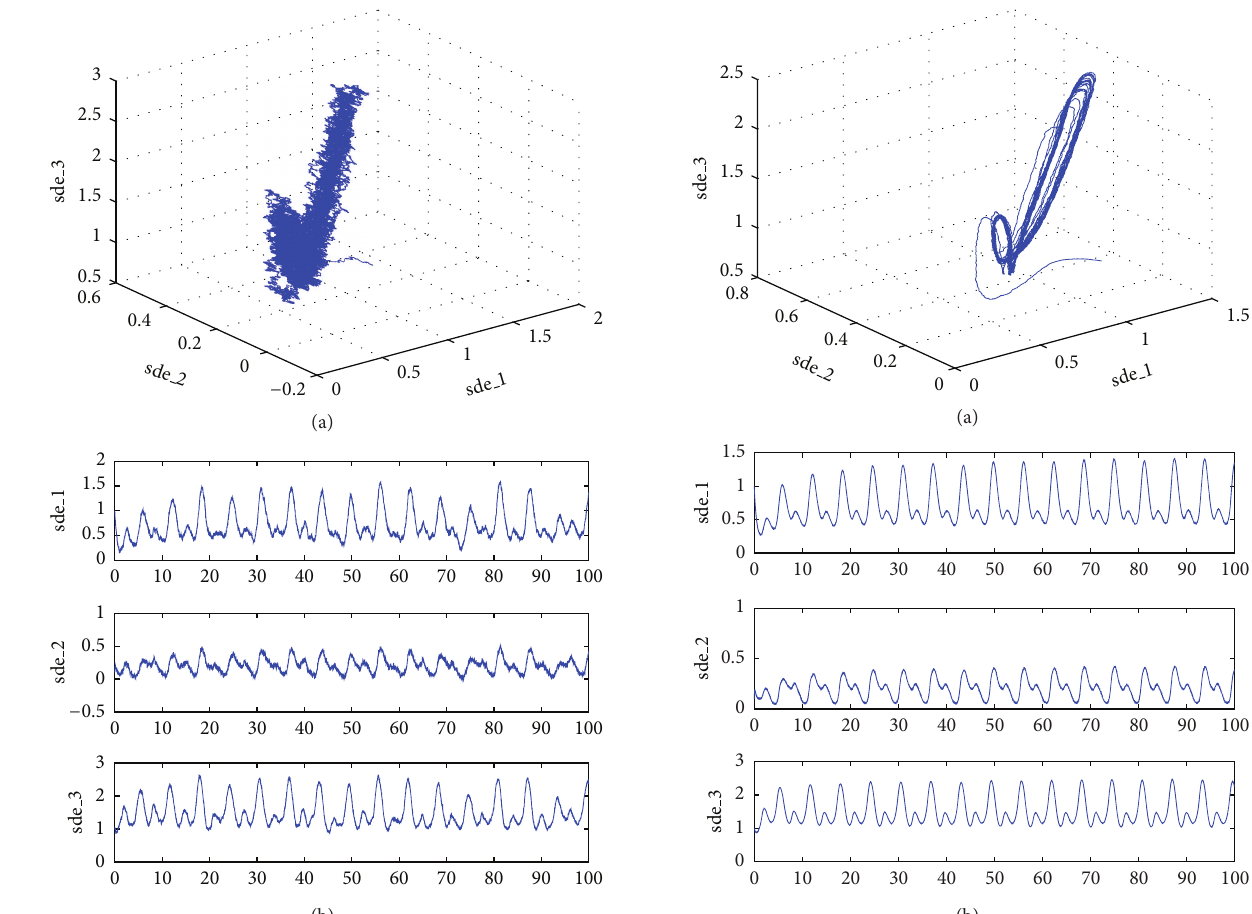
we consider 𝜎 = 12 , 𝑟 = −10 , 𝑎 = −7 , 𝑏 = 1 , 𝛽 = 2 , and 𝑐 = 0 and 𝛼 1 (𝑡) = 1/( sin 𝑡+2)+5/( sin (𝑡 2 )+2) , 𝛼 2 (𝑡) = 5/( sin (𝑡 2 )+2) , and 𝛼 3 (𝑡) = 1/( sin 𝑡 + 2) (Figures 11,